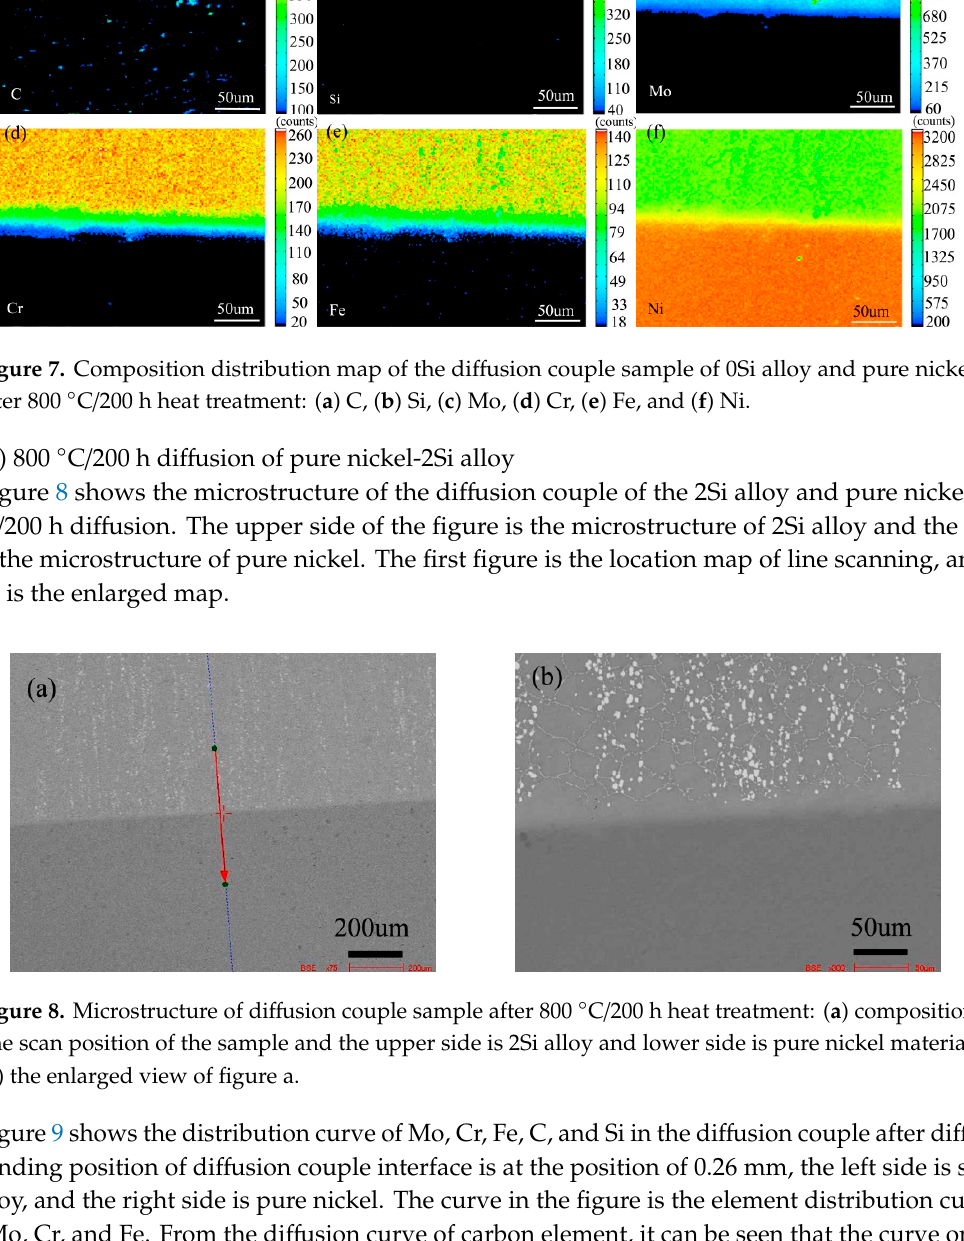
Figure 8. Microstructure of diffusion couple sample after 800 °C/200 h heat treatment: ( a ) composition line scan position of the sample and the upper side is 2Si alloy and lower side is pure nickel material, ( b ) the enlarged view of figure a.